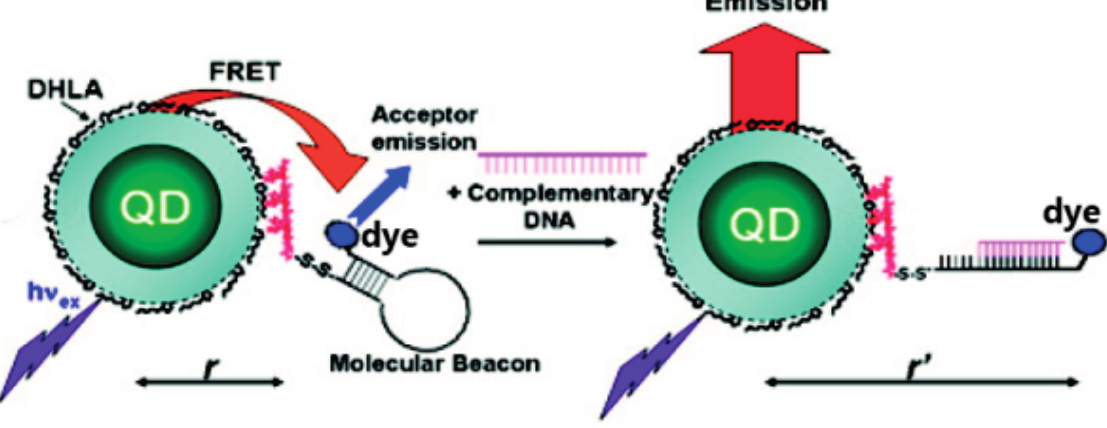
Figure 5. FRET is efficient between a nanocrystal and dye connected through a DNA hairpin linker. The addition of the complementary DNA (the analyte) changes the distance between the QD-dye complex. (Reprinted with permission from [84], Copyright 2007 American Chemical